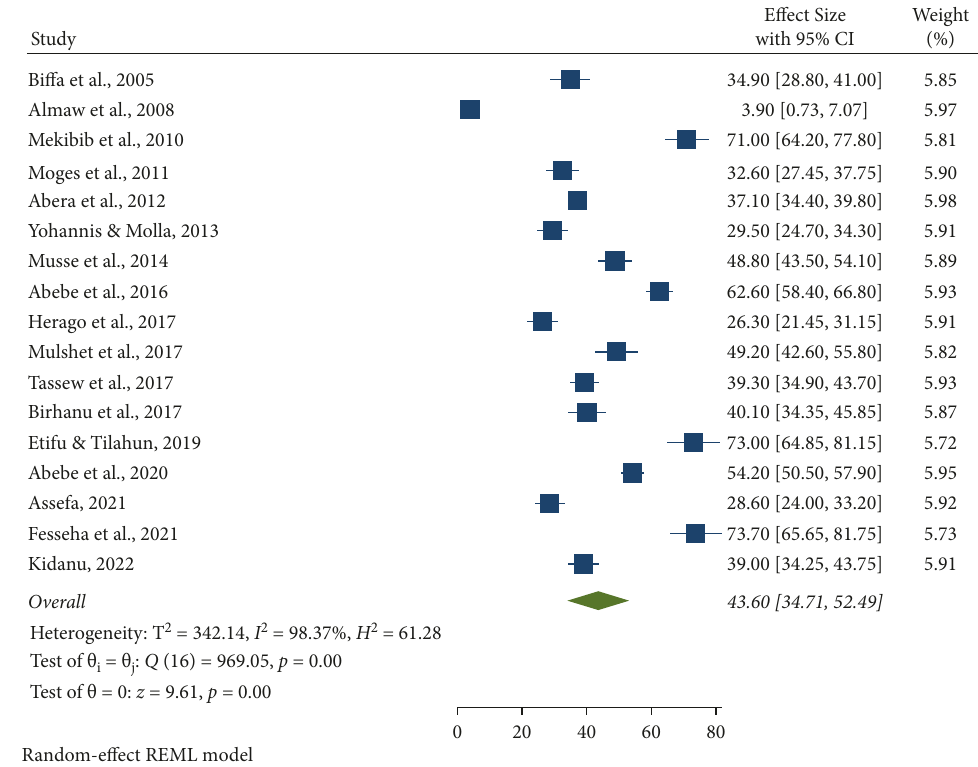
Figure 2: Forest plot of the pooled prevalence of bovine mastitis among dairy cows in Ethiopia from 2005 to 2022.